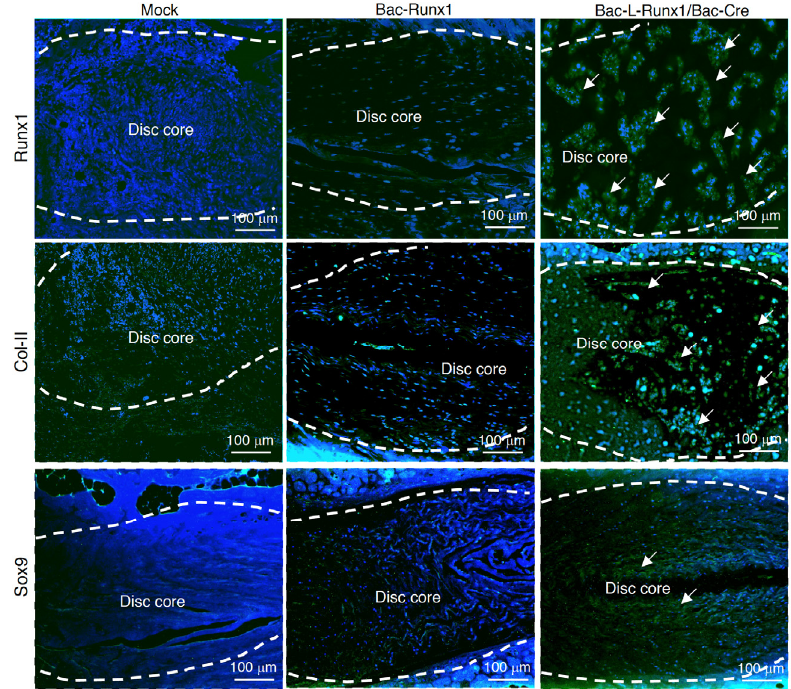
Figure 9. Jelly-like materials loss in the disc core was examined by immunohistochemical (IHC) staining. Discs were collected at 4 weeks post-transplantation, and the representative data shows the IHC staining using runx1, collagen type II, and sox9 1st antibodies, followed by Alexa488 conjugated 2nd antibody and DAPI staining. Runx1, collagen type II, and sox9 protein were maintained in the disc core at Bac-L-Runx1/Bac-Cre transduction, compared with Bac-Runx1 and mock transduction. A dashed line indicates the tissue margin between AF and NP, circles the disc core matrix. Arrows indicate the positive signals stained in the disc core. ( n = 3).